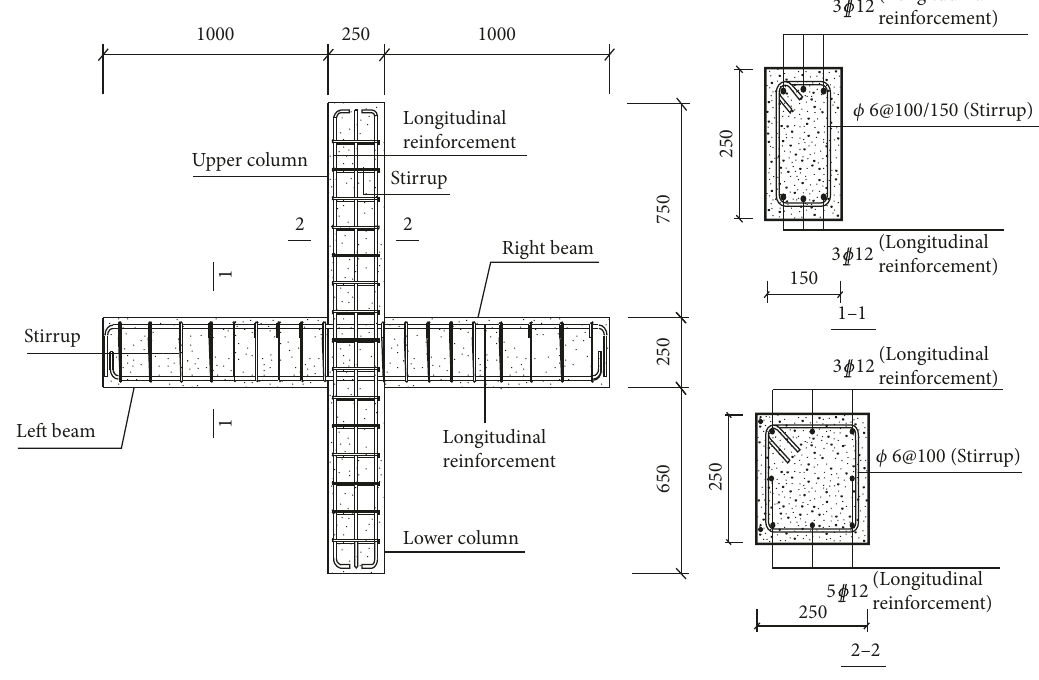
Figure 1: Details of the joint